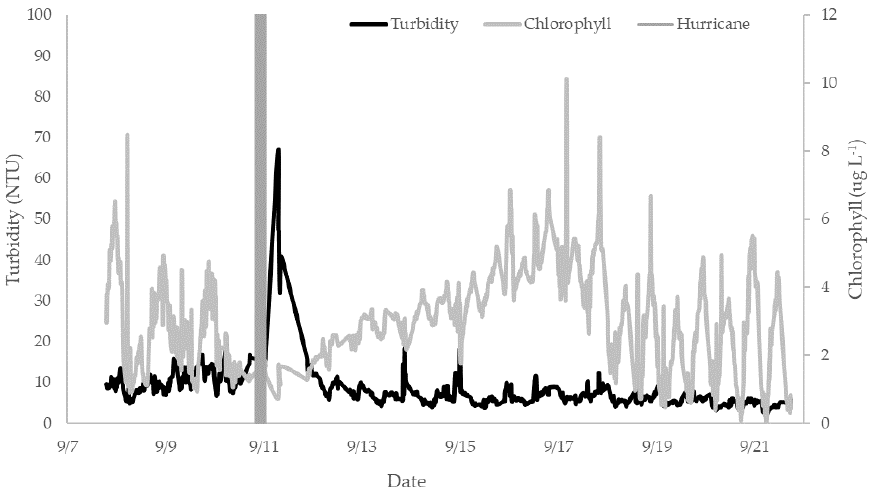
Figure 4. Turbidity and Chlorophyll- a measurements taken at the estuary sonde location during the storm. Chlorophyll data collected between the apex of the storm on 10 September 2017 and 12 September 2017 might be inaccurate due to potential interference from high turbidity levels.